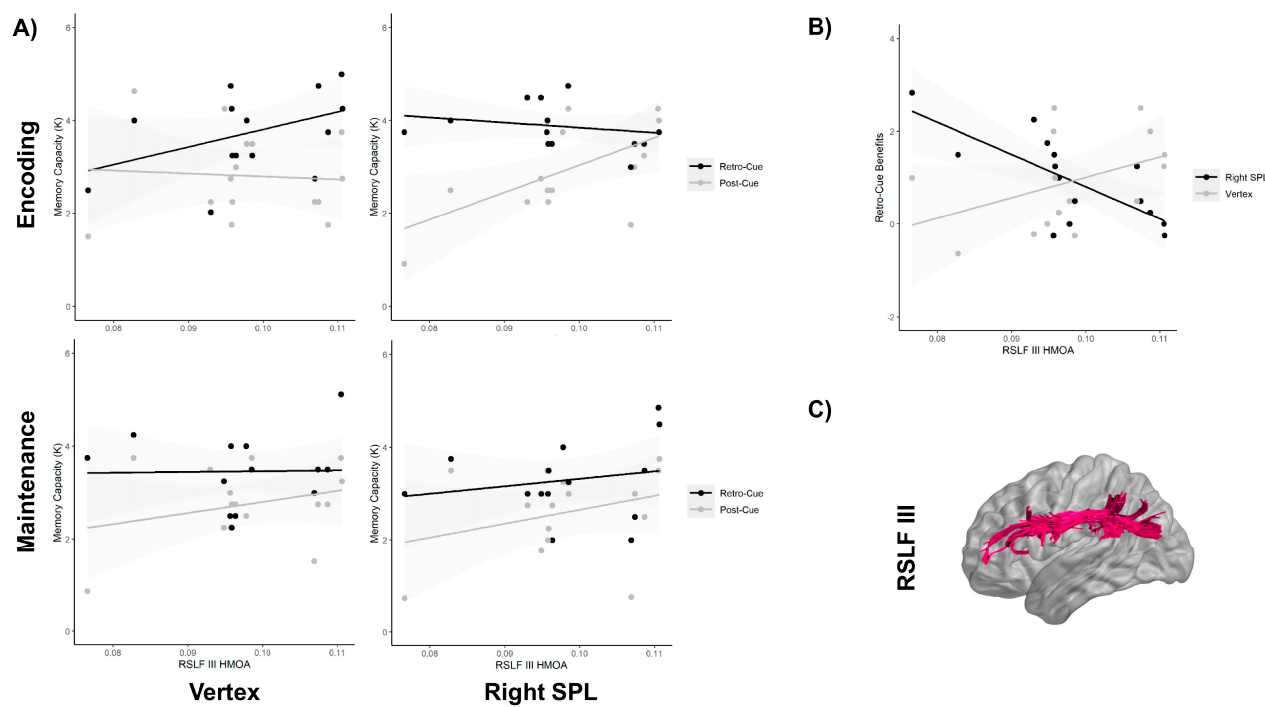
Figure 2. ( A ) Mean memory capacity (K) for each experimental condition of the cue type (retro-cue vs. post-cue; gray vs. black lines), stimulation site (right SPL vs. vertex; right vs. left panels) and stimulation time window (encoding vs. maintenance; upper vs. lower panels), depending on the hindrance modulated oriental anisotropy (HMOA) index of the right superior longitudinal fasciculus (RSLF-III). The shaded gray area around the lines is the 95% confidence interval. ( B ) Mean retro-cue benefits during the encoding phase, depending on the stimulation site (right SPL vs. vertex; black vs. gray lines). ( C ) Virtual in vivo dissection of the right SLF-III using deterministic tractography.